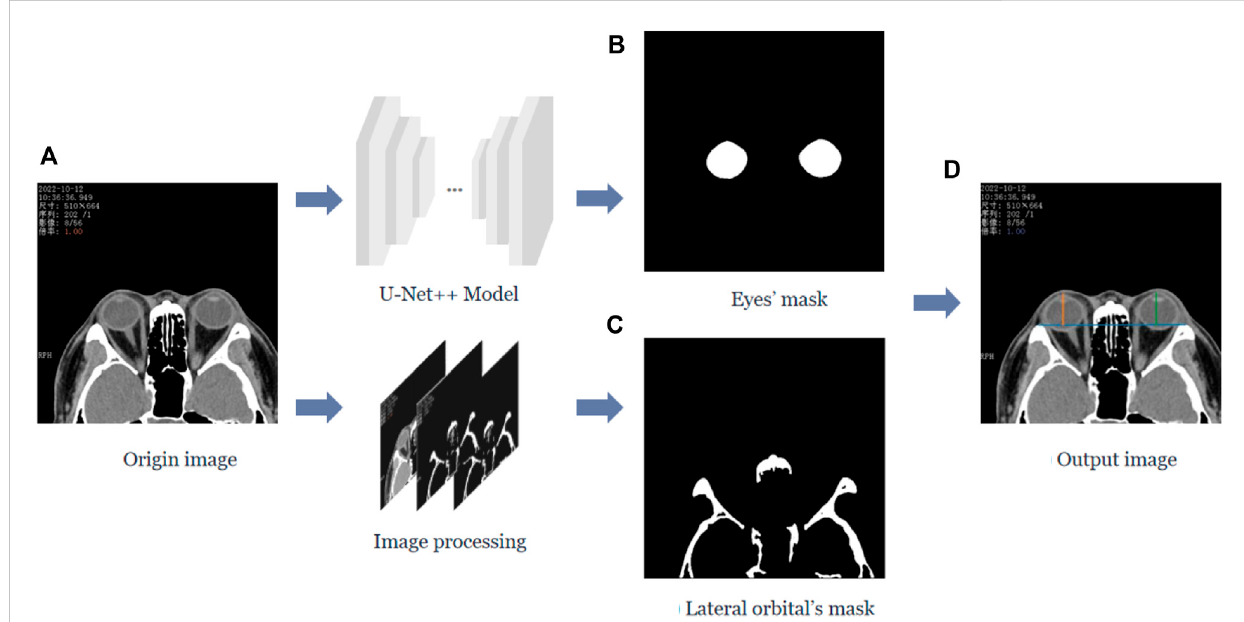
FIGURE 1 Process ofcalculatingtheverticaldistancefromtheapex oftheanteriorsurfaceofthecorneato thelateralorbitalrimofbotheyesintheaxialplane oftheCTimage. (A) The originalaxial planeoftheCTimage,and aftertheU-Net++modelandImageprocessing,wecanobtainthebinaryimagesofthe eyeregionmaskshownin (B) andthelateralorbitalrimregionofbotheyesshownin (C) ,respectively. (D) Thelinefromtheapexoftheanteriorsurfaceof theeyetotheapexofthelateralorbitalrimisrepresentedbythebluelinein (D) ,andtheverticaldistancefromtheapexoftheanteriorsurfaceofthe eye to the apex of the lateral orbital rim represented by the orange and green lines.